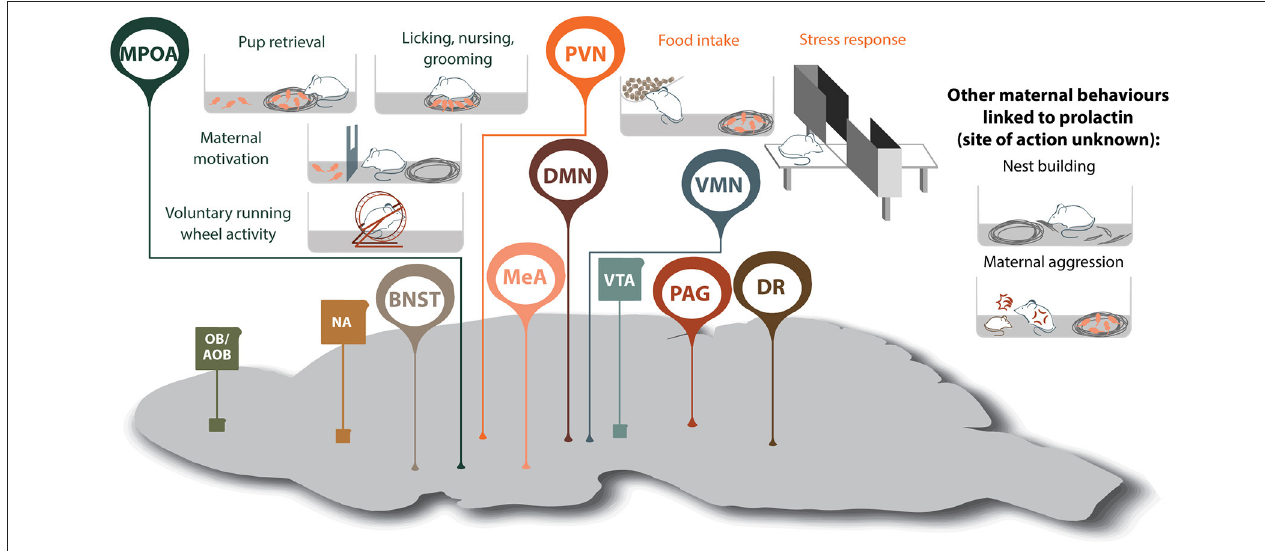
FIGURE 2 | Prolactin-regulated maternal behaviors governed by the maternal neural circuit. Within the neural circuit that regulates maternal behavior, many brain regions show increased prolactin receptor activity during lactation (shown in oval, whereas regions without Prlr but associated with maternal behavior are shown in squares). Note, that although prolactin has been shown to regulate additional aspects of maternal behavior, the brain regions mediating some of these effects are currently unknown. AOB, accessory olfactory bulb; BNST, bed nucleus of the stria terminalis; DMN, dorsomedial nucleus of the hypothalamus; DR, dorsal raphe nucleus; MeA, medial amygdala; MPOA, medial preoptic area; NA, nucleus accumbens; OB, olfactory bulb; PAG, periaqueductal gray; PVN paraventricular nucleus of the hypothalamus; VMN, ventromedial nucleus of the hypothalamus; VTA, ventral tegmental